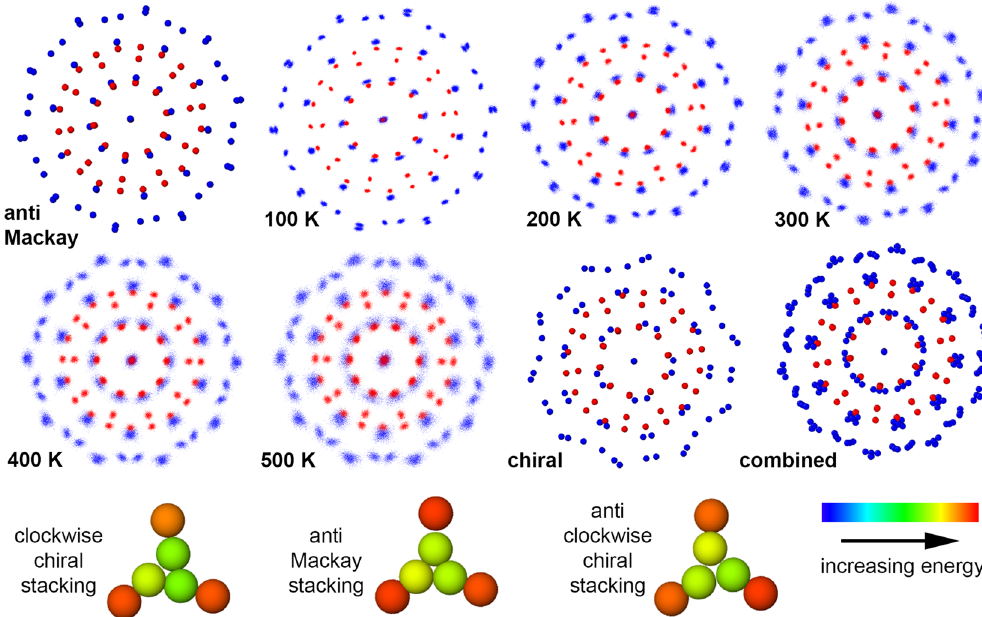
Figure 7. Structure of Ag Cu as a function of temperature (Ag in blue, Cu in red). The images labelled anti 72 55 Mackay, chiral, combined are for the perfect anti-Mackay, chiral icosahedron and a structure with atomic positions corresponding to anti-Mackay, clockwise and anti-clockwise chiral stacking. bottom row: the three different types of stacking that a {111}-like plane can adopt (atoms belonging to the {111}-like plane coloured in